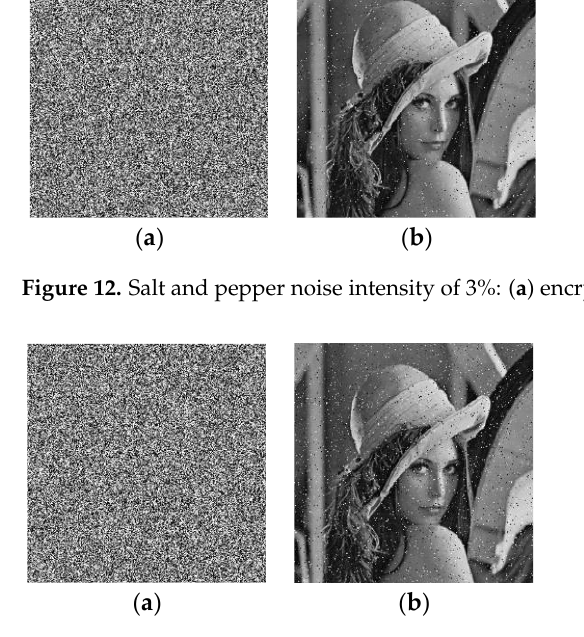
Figure 13. Salt and pepper noise intensity of 5%: ( a ) encrypted image and ( b ) decrypted